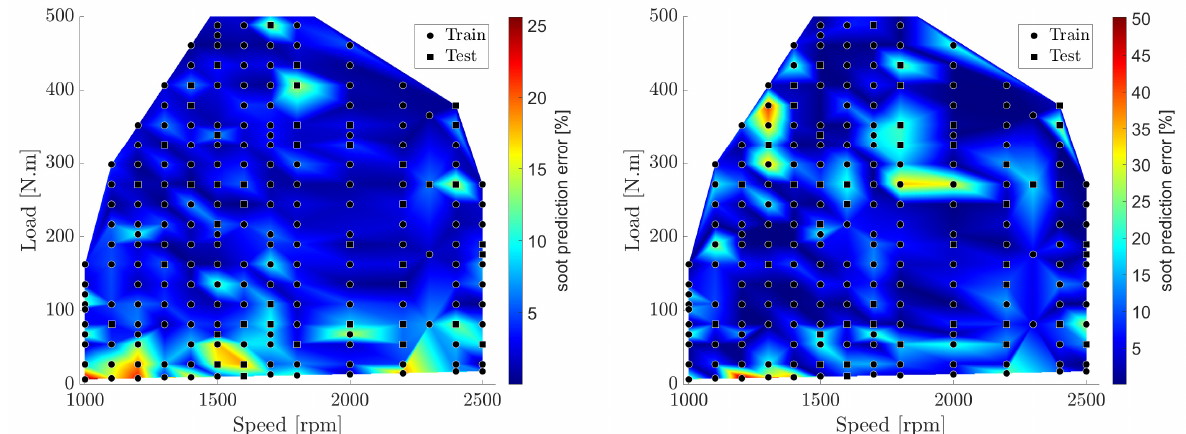
Figure 14. Prediction error [ % ] over engine speed and load for two models: ( a ) GPR: BB + L, ( b ) SVM: GB + PHYS +